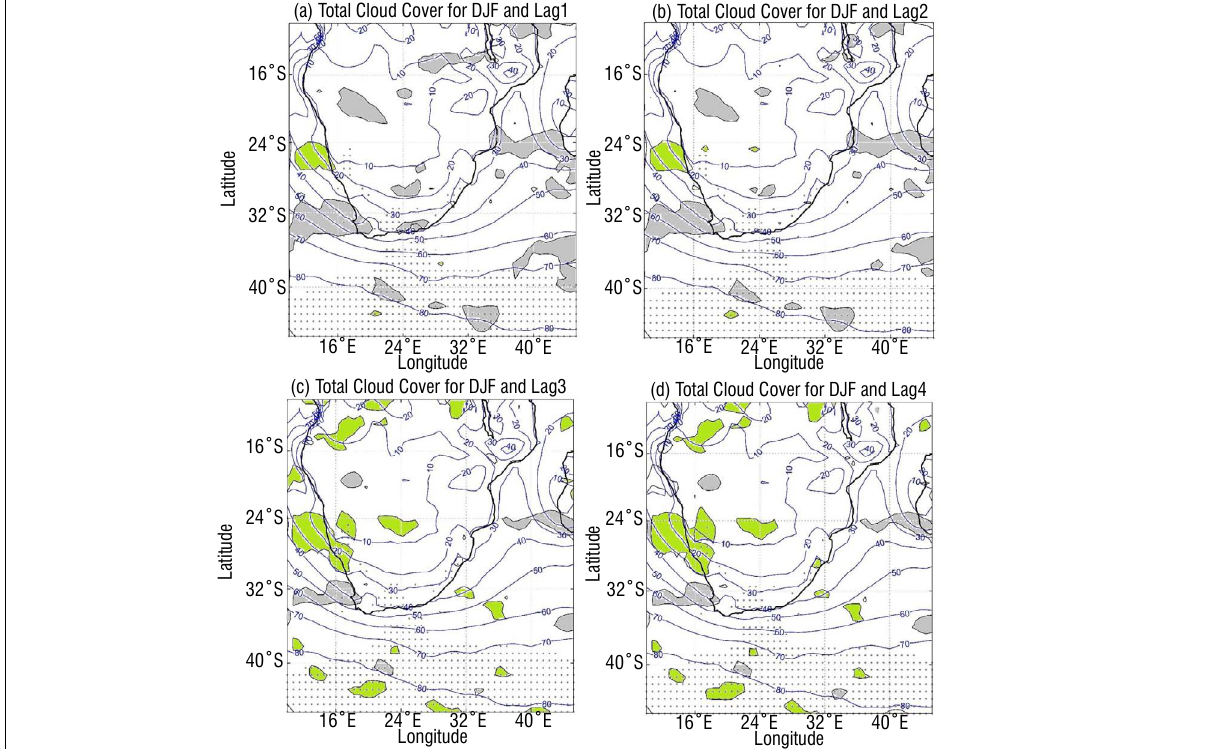
Figure 6: Total cloud cover area fraction (a–d) presented as percentage (contours) in June–August (JJA). Correlation coefficients for the Hadley cell and total cloud cover relation in JJA for (a) Lag 1, (b) Lag 2, (c) Lag 3 and (d) Lag 4. Grey shading denotes correlation coefficients greater than 0.3 and green shading indicates correlation coefficients less than -0.3. Regions of upward vertical velocity ( ω ) in Pa/s are represented by grey dots. Where there are no grey dots, there is downward motion (i.e. ω >